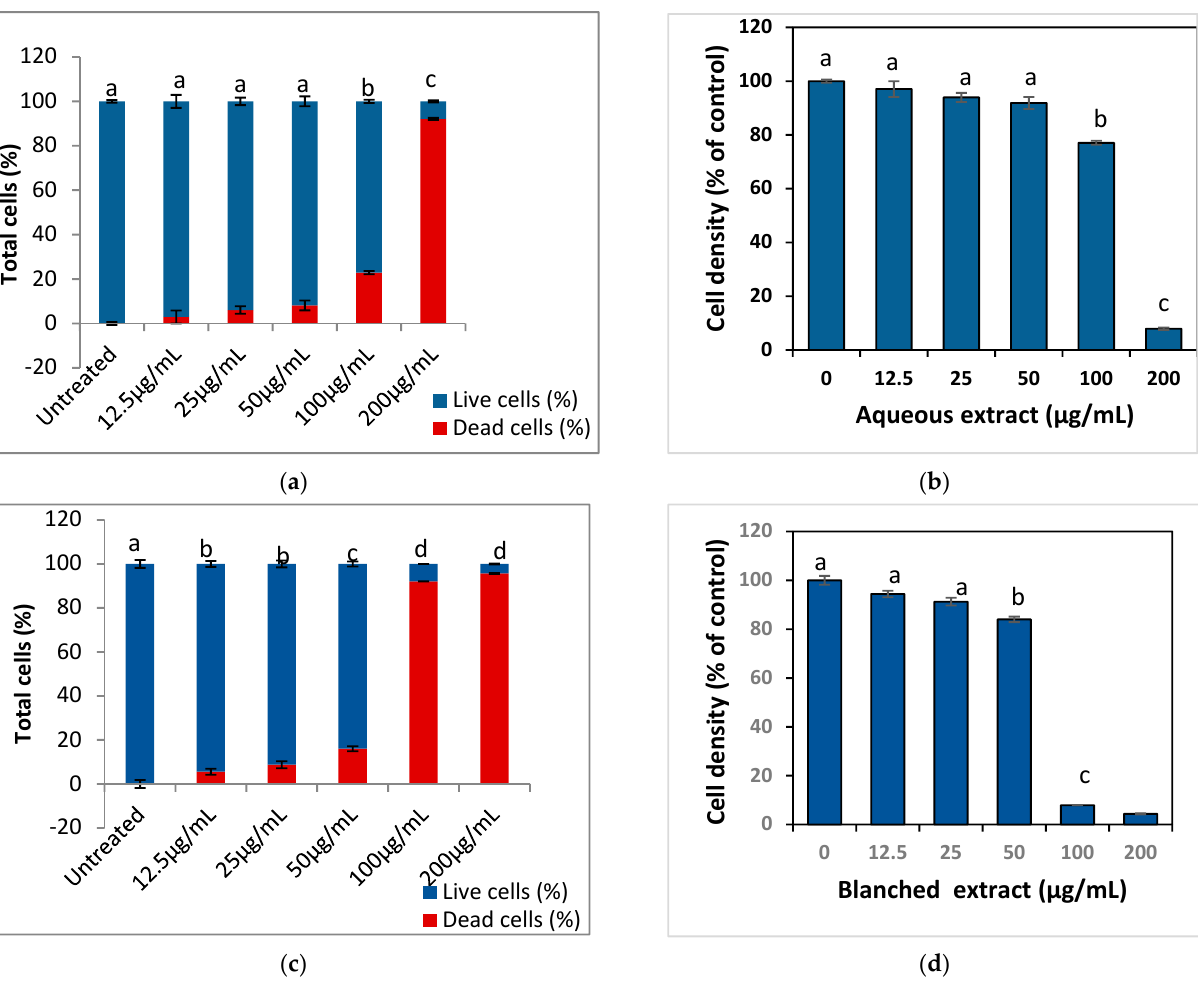
Figure 1. Cytotoxicity screening of aqueous and blanched extracts of H. arborescens leaves. ( a ) Total number of C3A cells after treatment with aqueous extract. ( b ) Cell density after treatment with aqueous extract. ( c ) Total number of C3A cells after treatment with blanched extract. ( d ) Cell density after treatment with blanched extract. Dead cells were represented as cells with compromised membrane integrity and subsequent propidium iodide (PI) staining and Live cells obtained from Hoechst 33,342 staining. Values are expressed as mean ± SD ( n = 2). Mean separation by SD ( p < 0.05). Set of bars with different alphabets are significantly